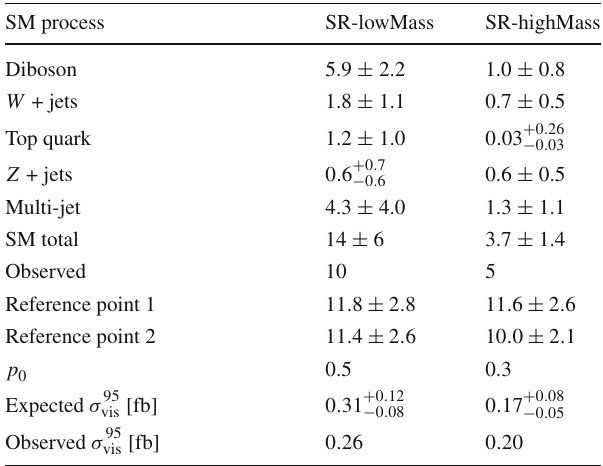
Table9 Observedandexpectednumbersofeventsinthesignalregions. The contributions of multi-jet and W + jets events are scaled with the normalisation factors obtained from the background-only fit described in Sect. 6.4. Expected event yields for the SUSY reference points (defined in Sect. 3) are also shown. The uncertainties correspond to the sum in quadrature of statistical and systematic uncertainties. The cor- relation of systematic uncertainties among control regions and among background processes is fully taken into account. The one-sided p 0 - values, the observed and expected 95% CL upper limits on the visible non-SM cross section ( σ 95 vis ) are given. Values of p 0 > 0 . 5 are